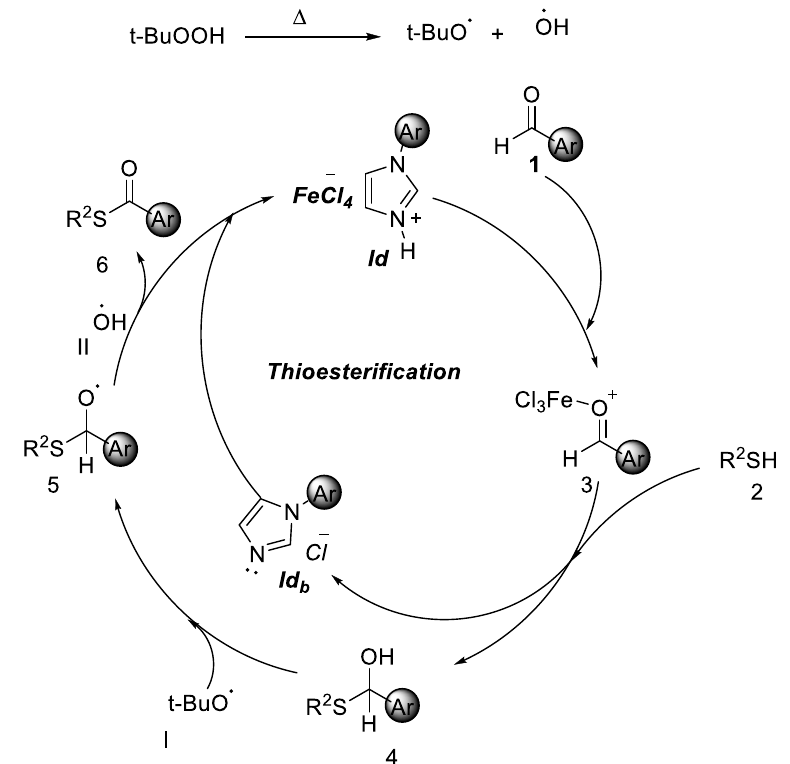
Figure 5. Proposed mechanism of thioesterification.